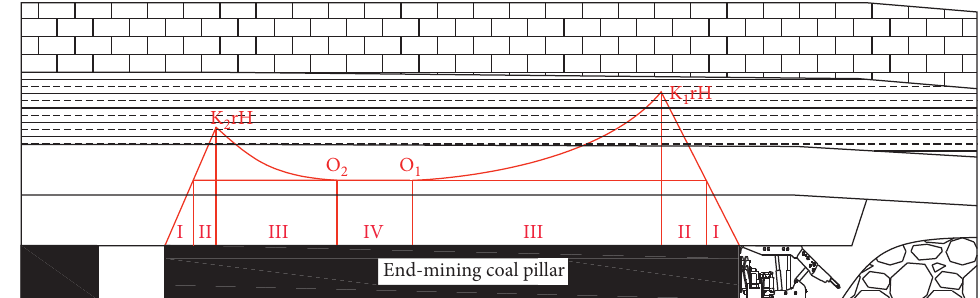
Figure 1: Stress distribution of the end-mining coal pillar.